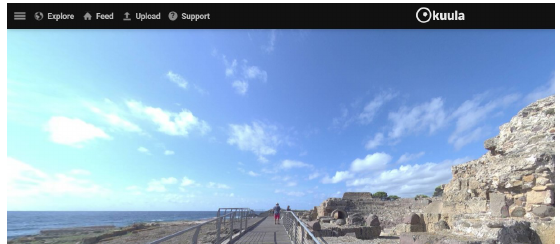
Figure 12. Point of view during the visit route following Figure 11 in which the white arrow appears to allow